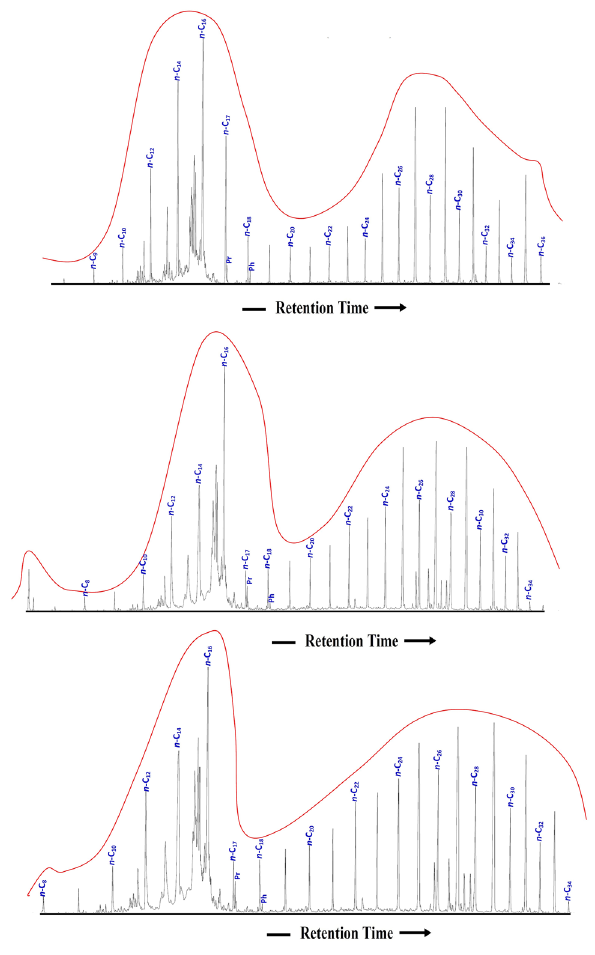
Fig. 6 Normal alkane and isoprenoid distribution according to m/z 85 of the three studied bituminite shale